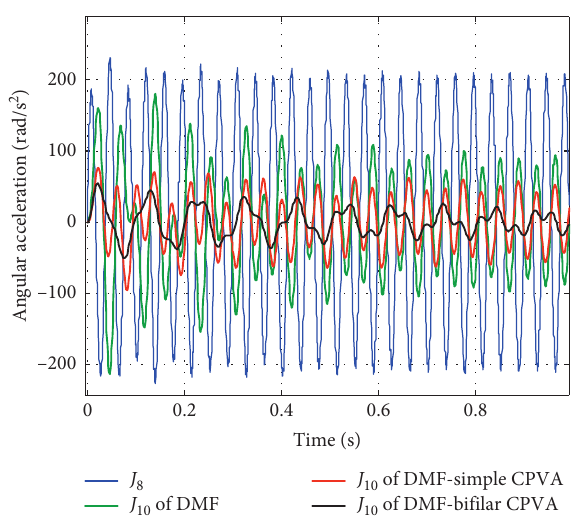
Figure 6: Angular acceleration curves of J